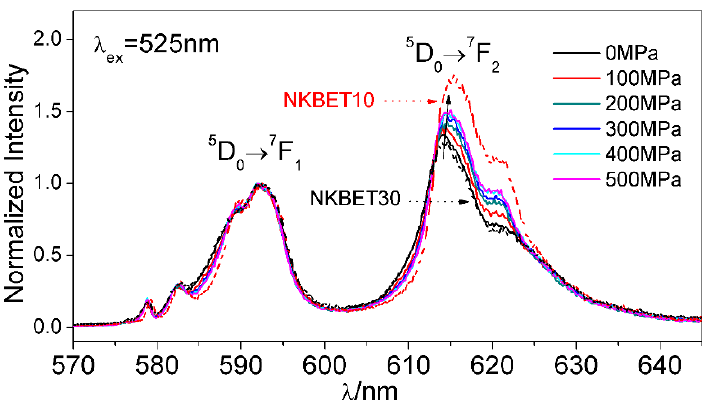
Figure 1. Photoluminescence (PL) spectra of the (Na 0.8 ,K 0.2 ) 0.5 Bi 0.497 Eu 0.003 TiO 3 (NKBET20) ceramic powders under various pressures. The peak intensity of the magnetic dipole (MD) transition 5 D 7 F is normalized to 1; the dashed lines represent the PL spectra of the NKBET10 and NKBET30 ceramic powders; the black arrow represents the variations of the PL spectra.